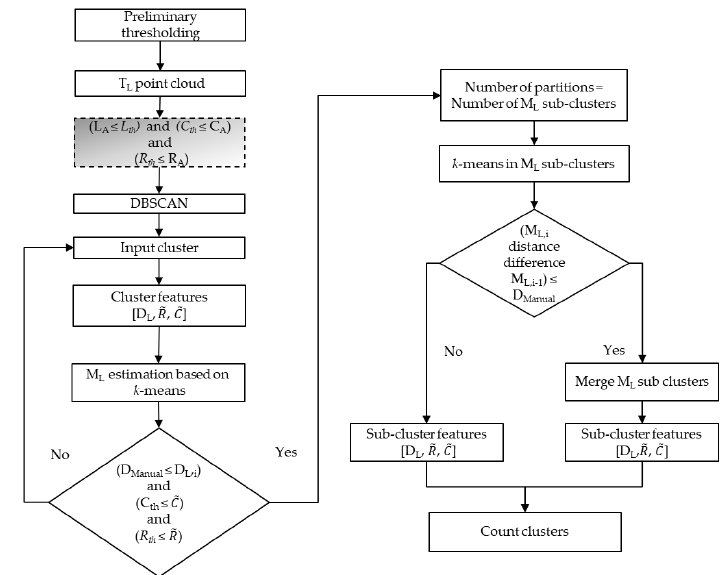
Figure 2. Flowchart of the validation showing the protocol for apple detection and sizing using foliated (T L ) trees, starting with the threshold application in the registered point cloud, through the filtering and partitioning, until the counting of centers of clusters. The cell with shading and dashed frame point out the inclusion of leaf class in the analysis .